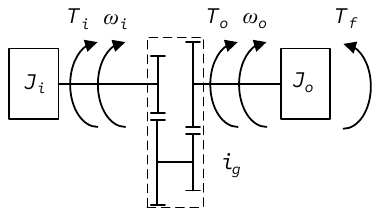
Figure 4. AMT driving model.